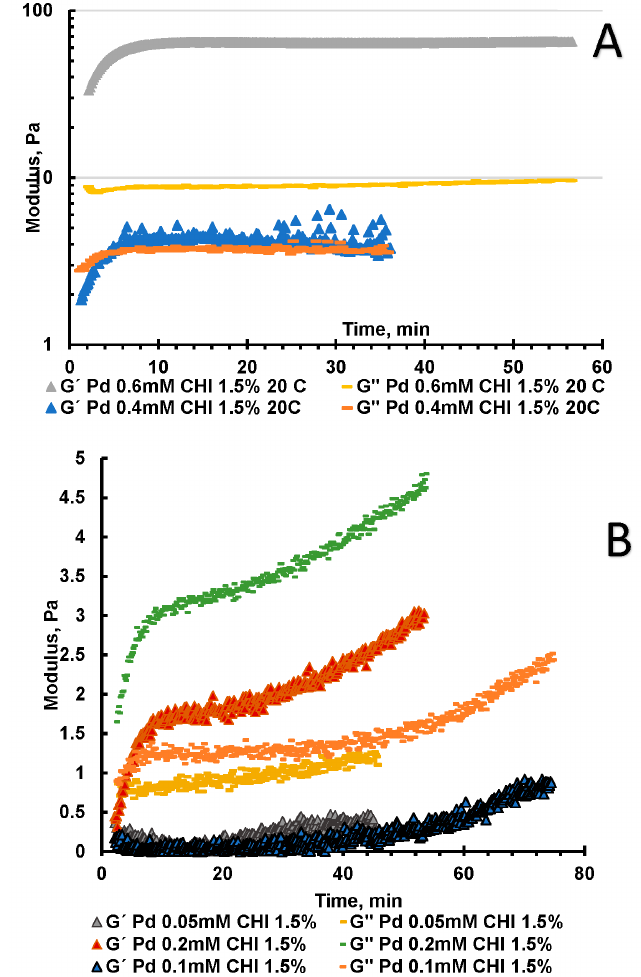
Figure 3. Monitoring the kinetic of formation and stability of gels using oscillatory shear rheology. Storage modulus, G′, and loss modulus, G′′. G′ and G′′ as a function of the shear stress amplitude σ for f = 1 Hz: ( A ) Kinetics of CHI-[PdCl 4 ] 0.4 mM and 0.6 mM hydrogel formation at pH 5.6 and 20 ◦ C; ( B ) Kinetics of CHI-[PdCl 4 ] 0.05 mM, 0.1 mM and 0.2 mM hydrogel formation at pH 5.6 and 20 ◦